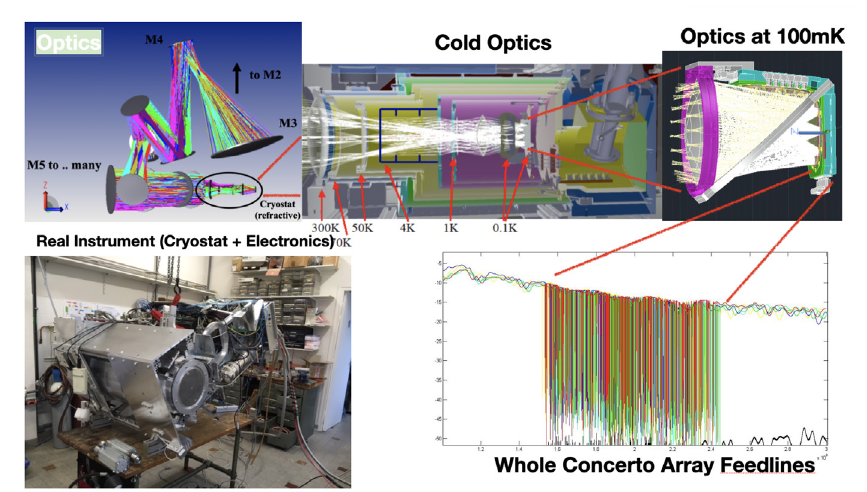
Figure 1. Top: CONCERTO optical design (using Zemax software with details of the cold optics inside the cryostat and the 100mK stage cold pupil, polariser and the two arrays). Bottom left: picture of the fabricated CONCERTO cryostat and warm electronics in the laboratory at Neel in Grenoble. Bottom right: baseline sweeps for one array (6 feedlines) taken with Vector Network Analyser (VNA).